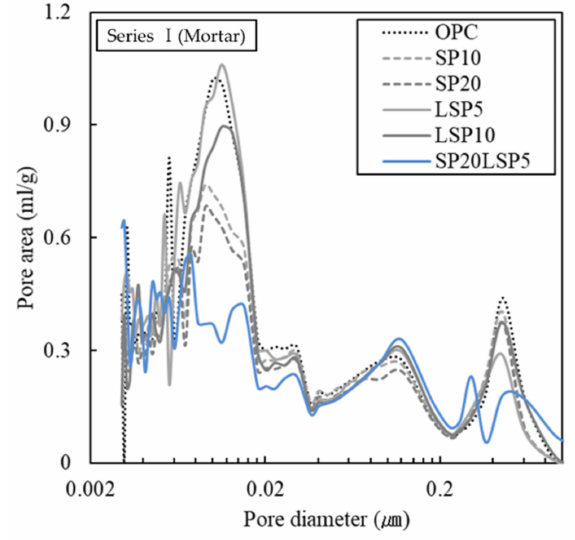
Figure 3. MIP measurement result of binder specimens at 28 days. Table 5. Volume classification by pore size of binder type at 28 days (Series